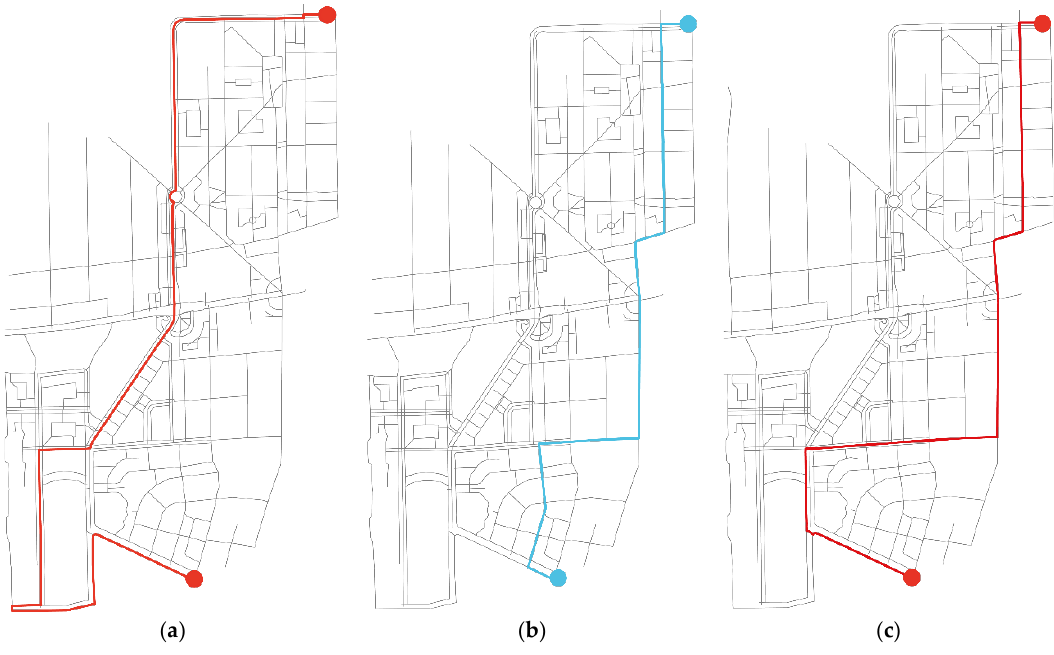
Figure 3. Shortest path findings with the influence of ( a ) the shortest block-distance path from two points; ( b ) choice in between; ( c ) the fewest number of turns path from two points.